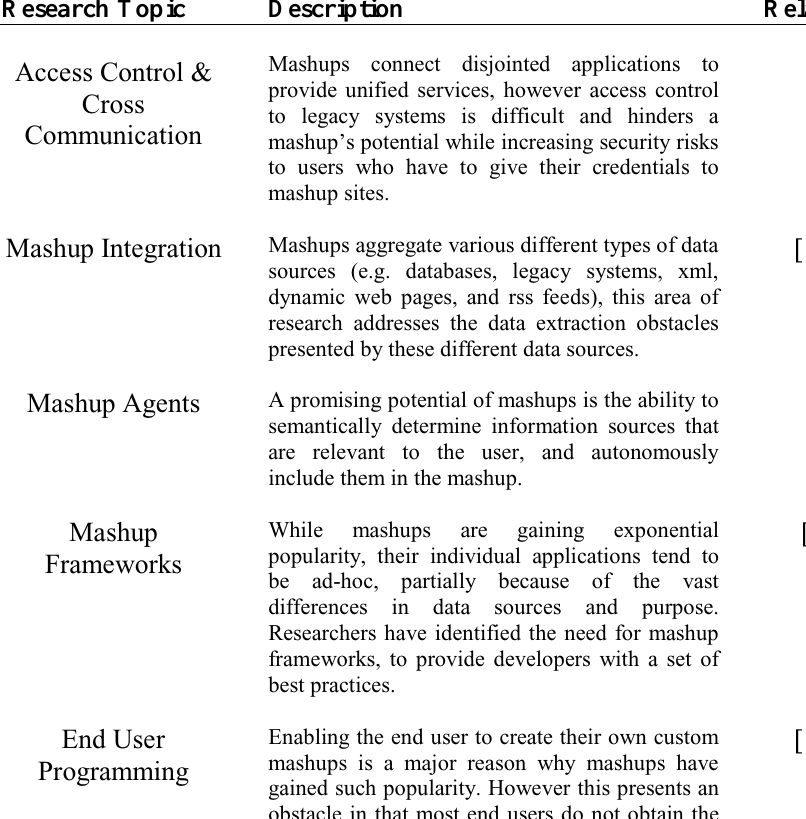
Table 1. Mashup Research